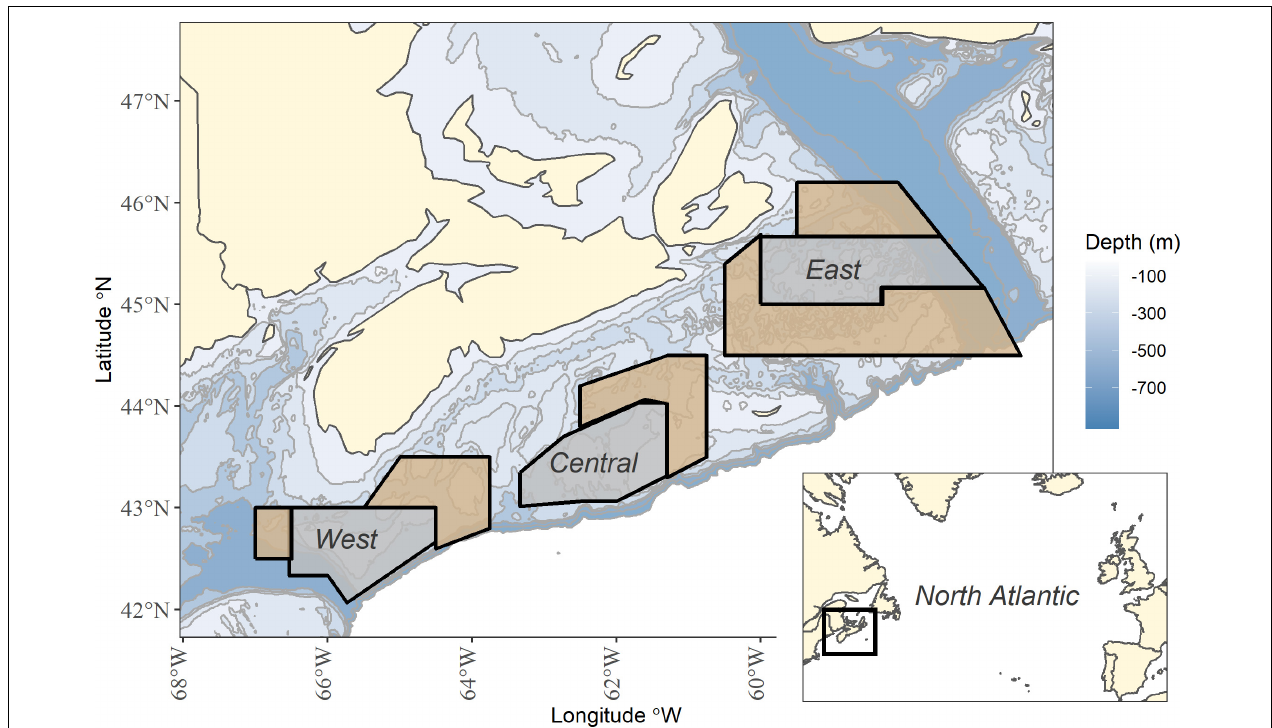
FIGURE 1 | Long-term fleet closures (gray) and adjacent open areas (tan) in the west, central and east on the Scotian Shelf, Canada. Map inset shows study location within the North